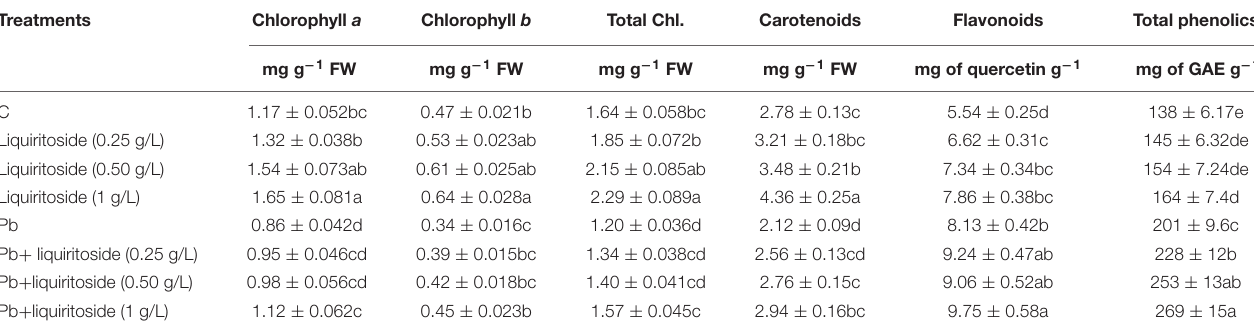
TABLE 2 | Effect of liquiritoside on chlorophyll, carotenoids, flavonoids, and phenolics levels of Chinese flowering cabbage plants under lead (Pb) stress.